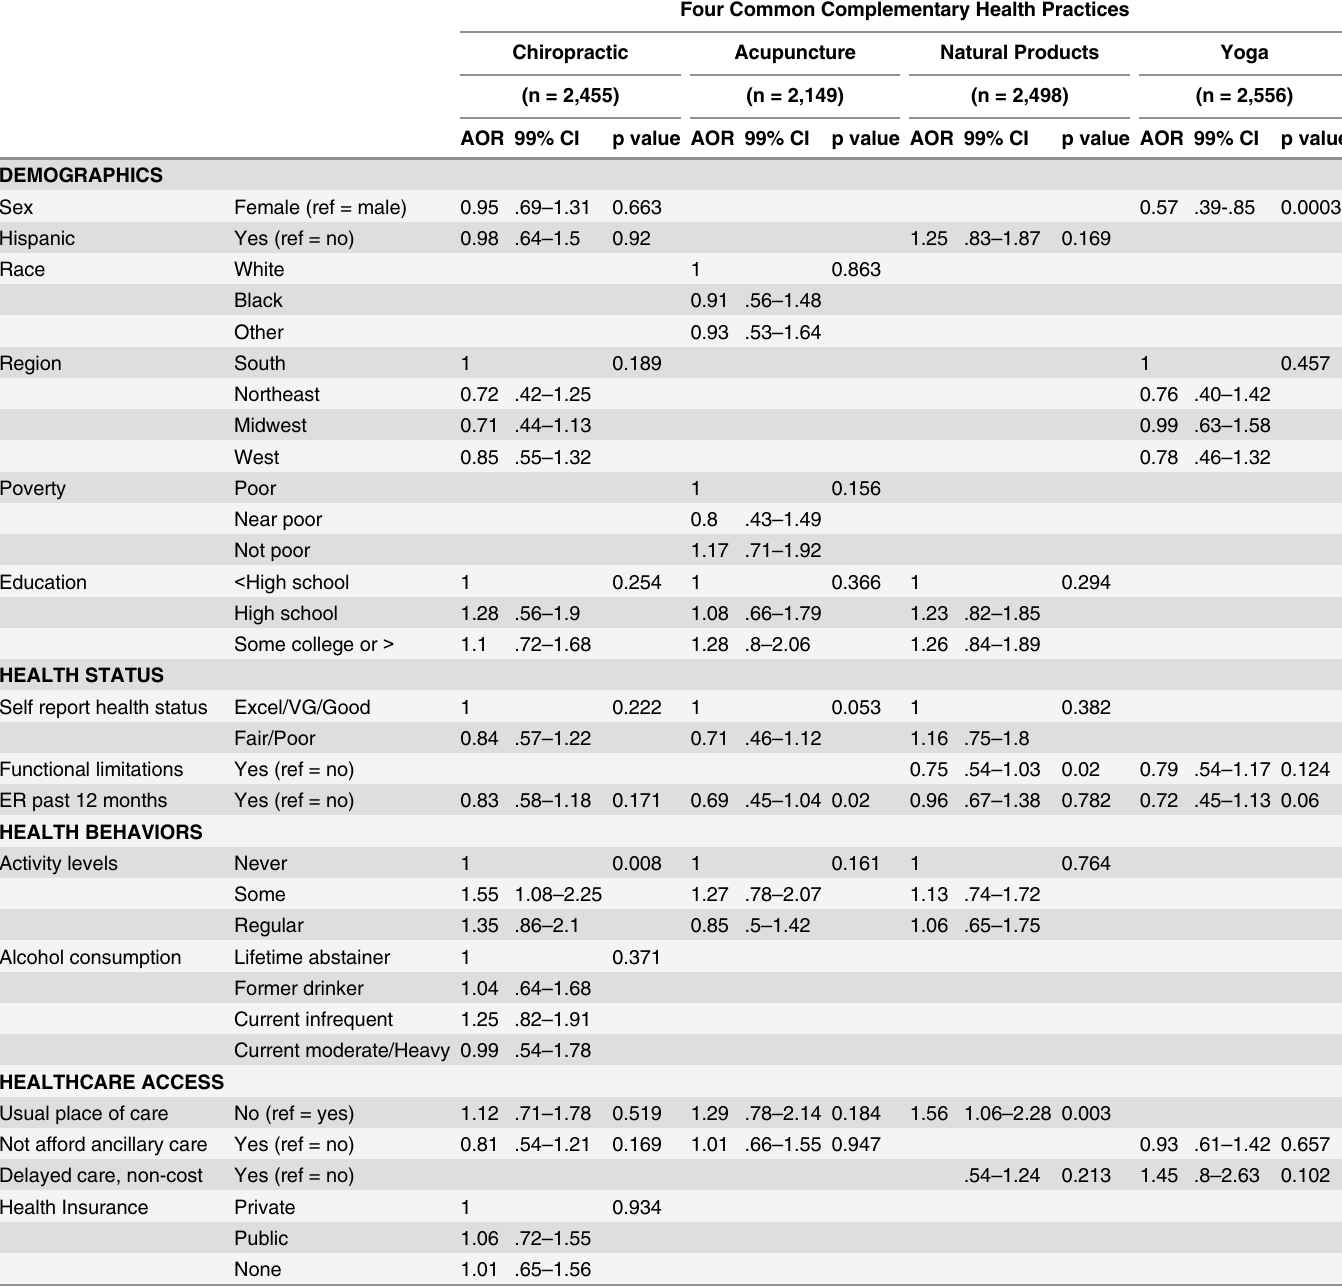
Table 5. Adjusted odds ratios and 99% confidence interval estimates of items independently associated with choosing 'lack of need' as a reason for non-use of four complementary health practices, back pain only